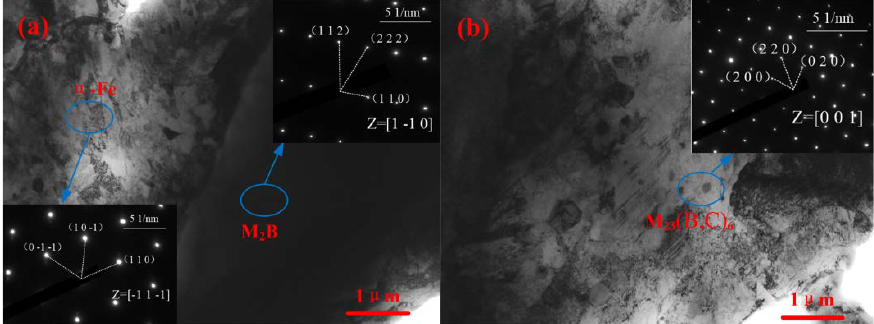
Figure 4. Bright-field TEM micrographs and corresponding selected area diffraction patterns of the matrix, M 2 B, and M 23 (B,C) 6 . ( a ) A1 sample; and ( b ) A2 sample.